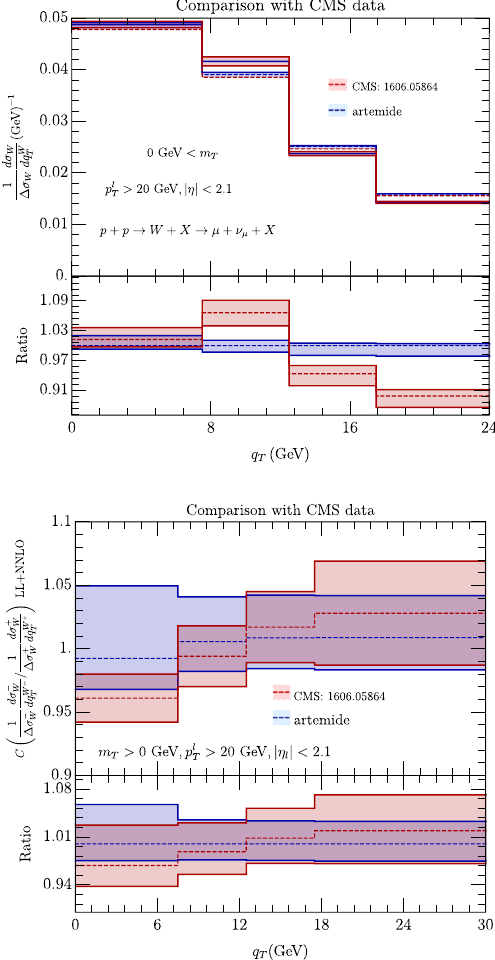
Fig. 13 Comparison of our prediction with data from CMS in [21]. final state, (top right panel) W boson normalized spectrum for muon final state, (bottom left panel) W / Z ratio of transverse momentum nor- Theoretical predictions include error coming from scales variation. The > 25 GeV, p ν > 20 GeV, malized spectrum, (bottom right panel) W + / W − ratio of transverse CMS data are always evaluated for p l T T | η | < 2 . 4.(Top left panel) W boson normalized spectrum for electron momentum normalized spectrum l